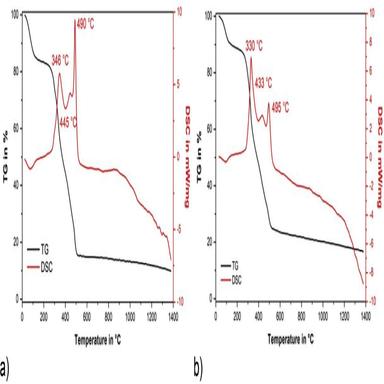
Thermal analysis of the as-spun fibers a) 3Y–Zr and b) 10Mg–Zr in synthetic air up to 1380 °C, heating rate 10 K/min.